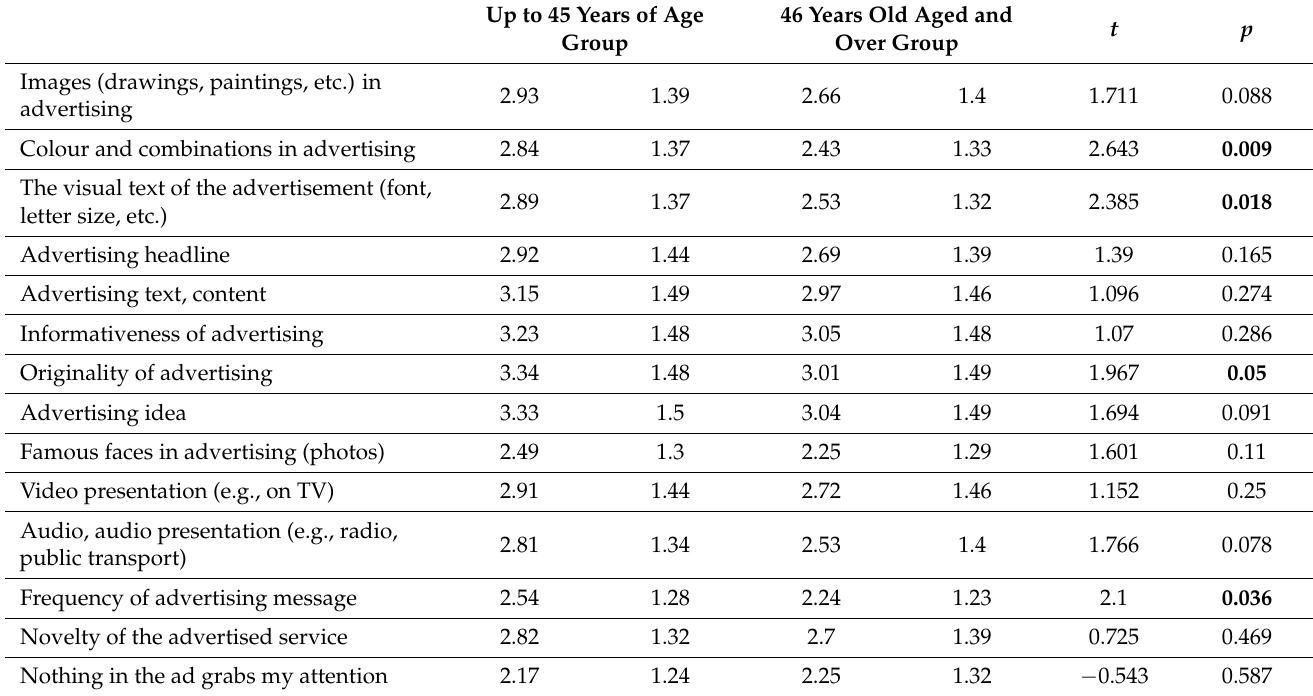
Table 4. Evaluation of advertising elements influencing the decision to travel on the basis of sustain- able mobility and multimodality for different age groups ( t -test for independent samples). Up to 45 Years of Age 46 Years Old Aged and t Group Over Group